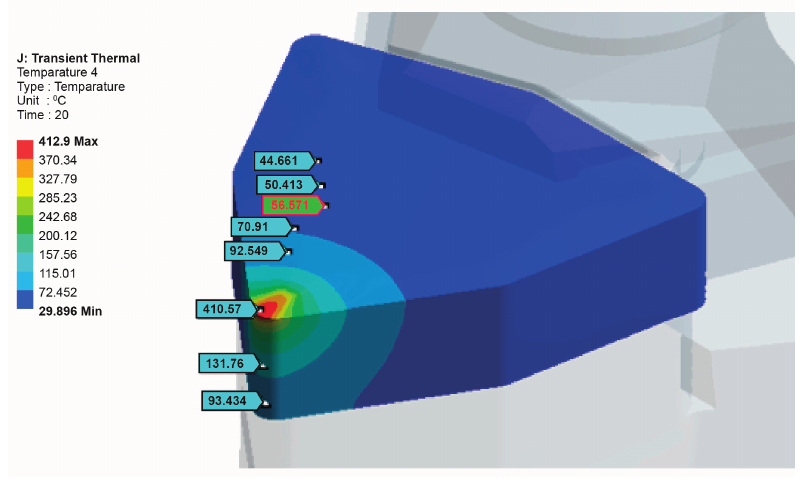
Figure 17. Temperature probe values for some